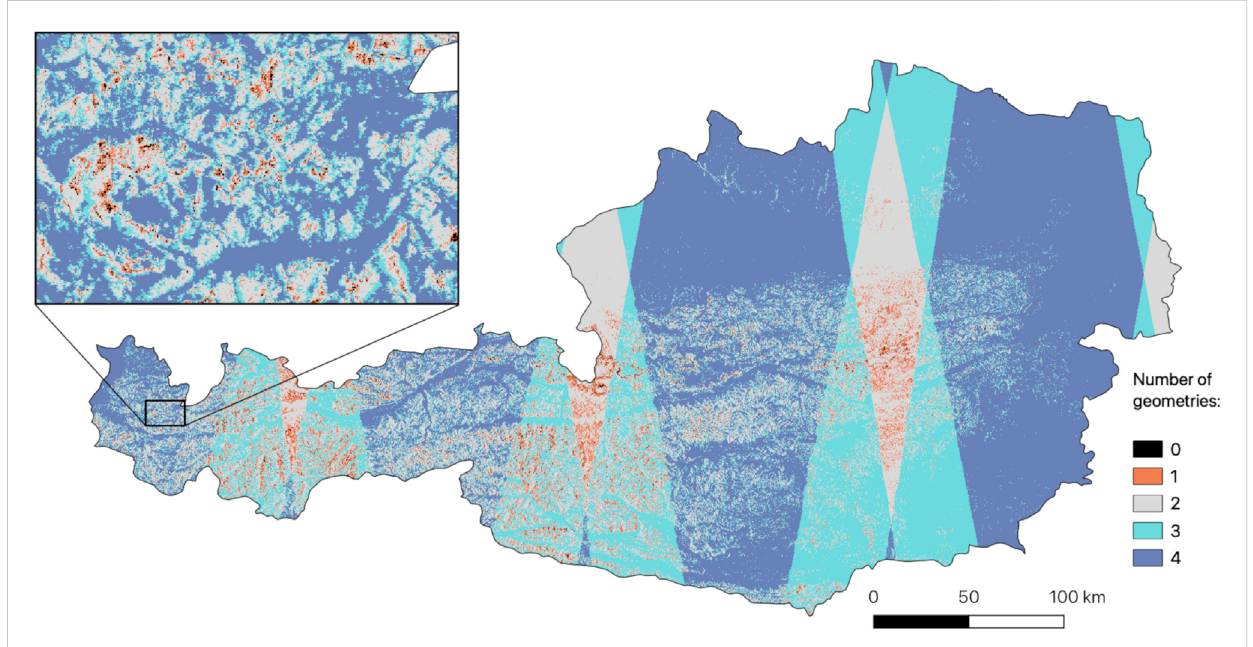
FIGURE 2 MapshowingthesatellitecoverageofAustriabytheSentinel-1satellites,quanti fi edasthenumberofsatellitegeometries(relativeorbits)fromwhich an area of interest is visible. The coverage is limited by the swath width of the radar, as well as radar layover and shadowing due to the topography. Since theradarissidelookingandtheorbitsareorientedroughlynorth-south,radarlayoverandshadowingeffectsaremostsevereinterrainwithsteepeasterly or westerly slopes. However, only very few areas are not covered at all (indicated in black). Created with